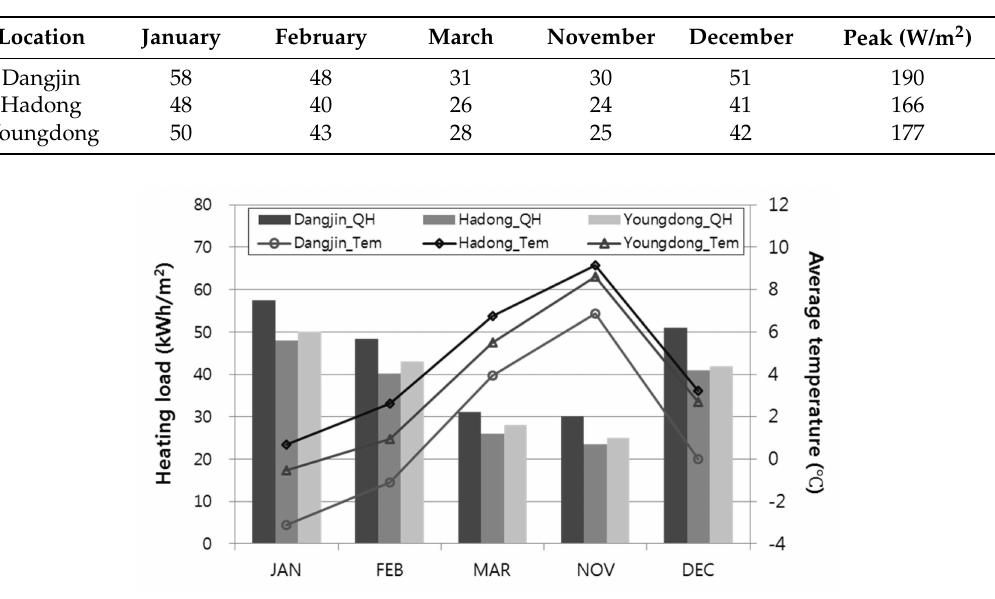
Table 4. Heating load of each case area (kWh/m 2 ).